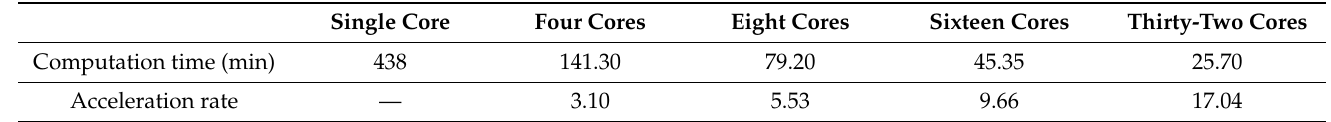
Figure 8. The average STDs of multi-GNSS phase OSBs from DOY 290, 2021 to DOY 310, 2021. Table 5. Computation time and acceleration rate using a different